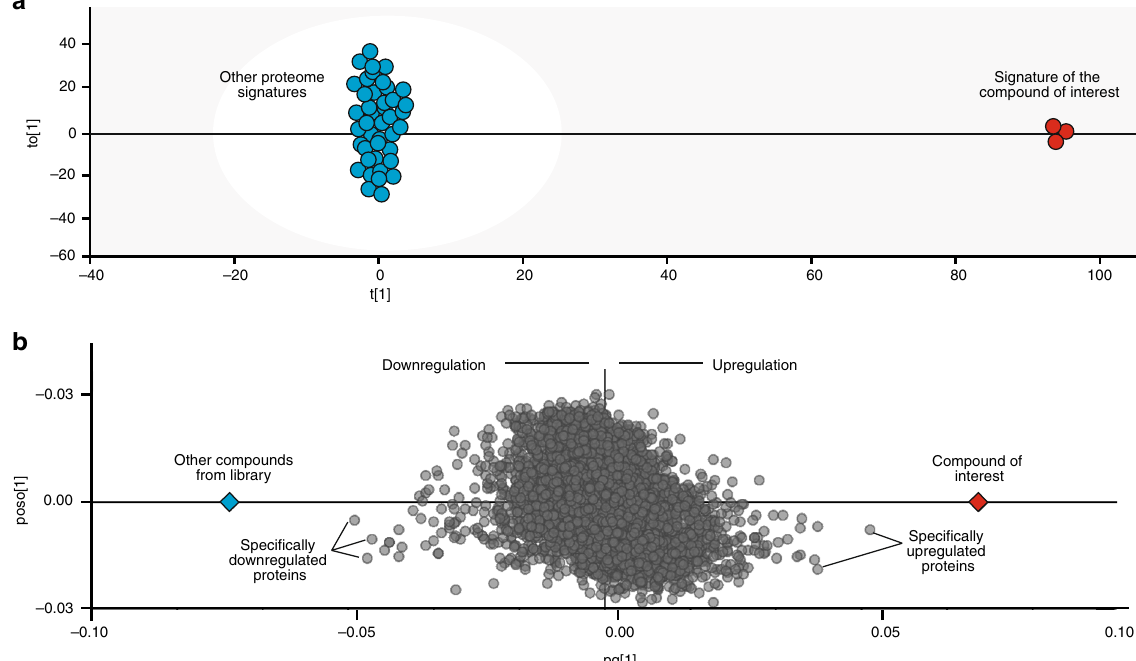
Fig. 3 OPLS-DA paradigm. a a generalized OPLS-DA model contrasting a given compound proteome signature against all others. b the OPLS-DA loading or score scatter plot demonstrating proteins most contributing to class re fl ects compounds ’ MOA. As an example, processes enriched for 30 top speci fi cally up-regulated proteins in methotrexate treat- ment are deoxyribonucleoside monophosphate biosynthetic process ( p < 1E-6) and tetrahydrofolate metabolic process ( p < 7E-6) and the enriched function is folic acid binding ( p < 5E-5), in line with the known drug mechanism.